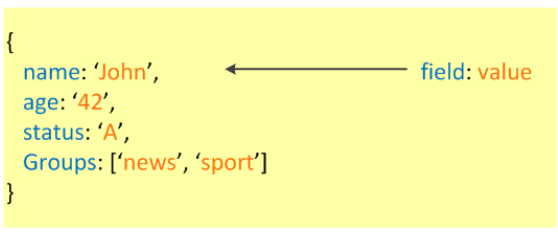
Figure 3. Example of a MongoDB document.